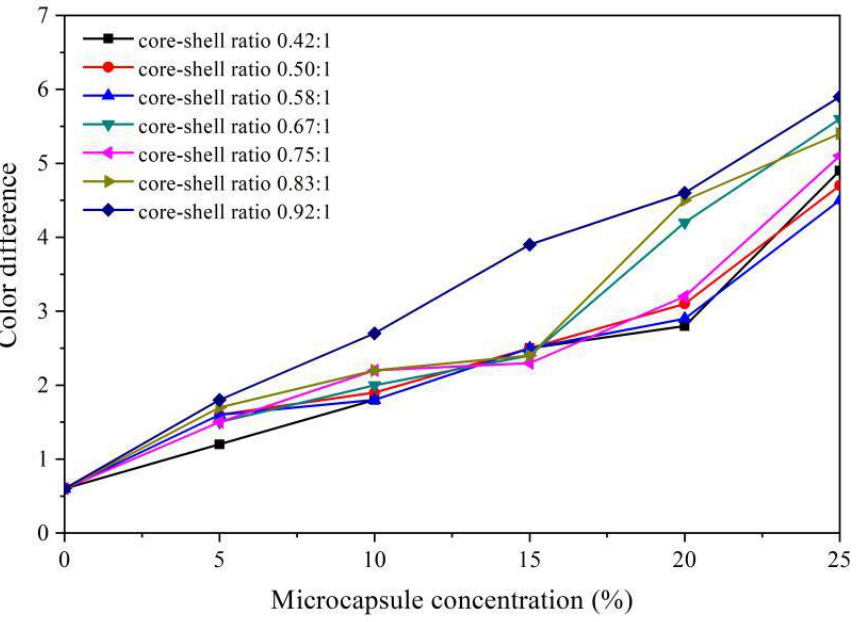
Figure 1. Effect of microcapsule concentration and core-shell ratio on the color differences of paint film.